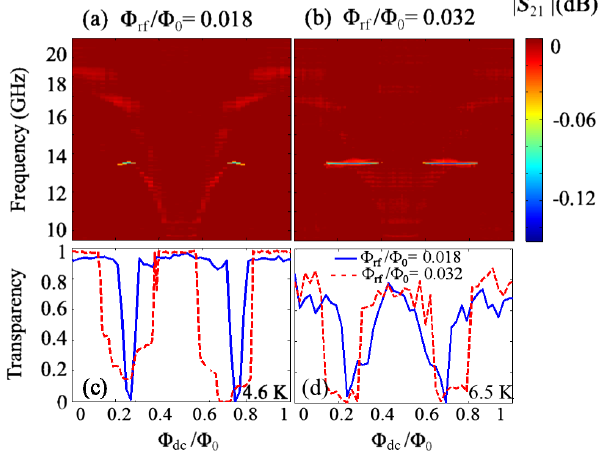
FIG. 5. The measured transmission at 4.6 K of a single rf SQUID meta-atom as a function of dc flux and frequency at different drive amplitudes: (a) rf flux ¼ 0 . 018 Φ 0 , (b) rf flux ¼ 0 . 032 Φ 0 . Dark red is the perfect transmission background; light red and blue features denote the weak and strong resonance absorption, respectively. The extracted transparency values for rf flux amplitude of 0 . 018 Φ 0 (dashed red line) and 0 . 032 Φ 0 (solid blue line) are shown for (c) 4.6 K and (d) 6.5 K. They both show a clear switchable transparent behavior by dc